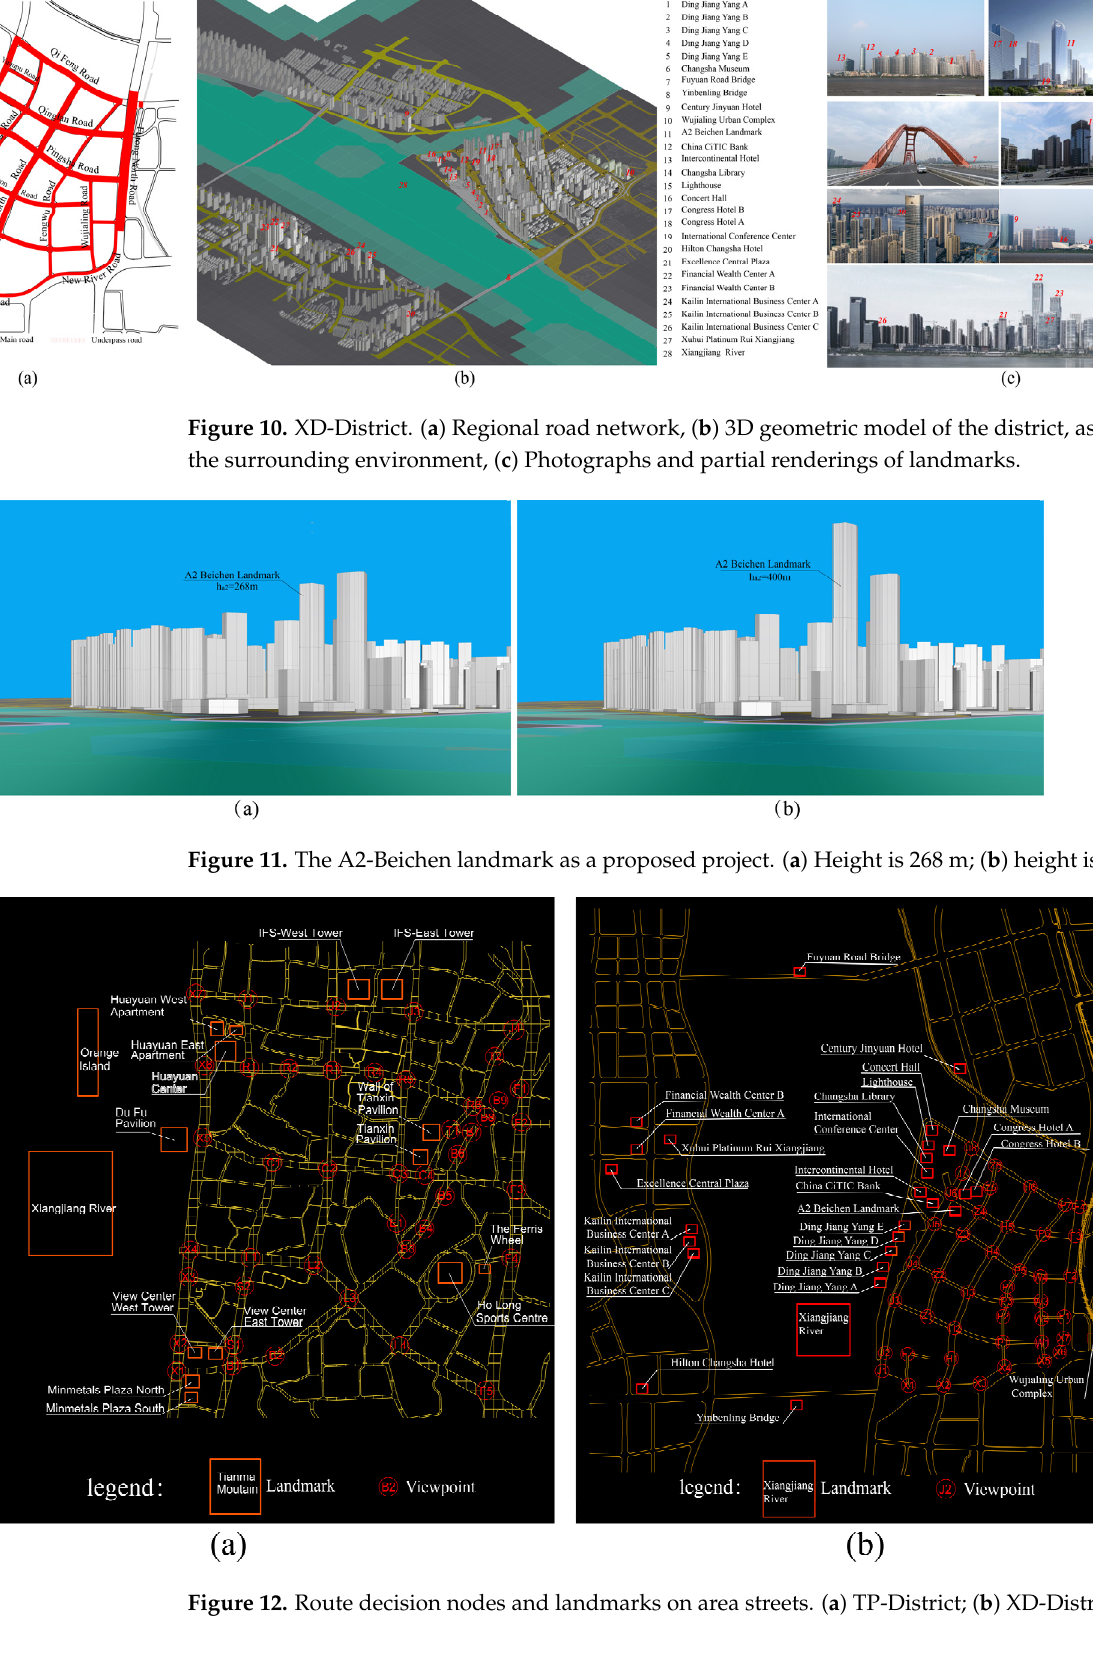
Grasshopper platform, the initial setup parameters of the 3D isovist are kept consistent